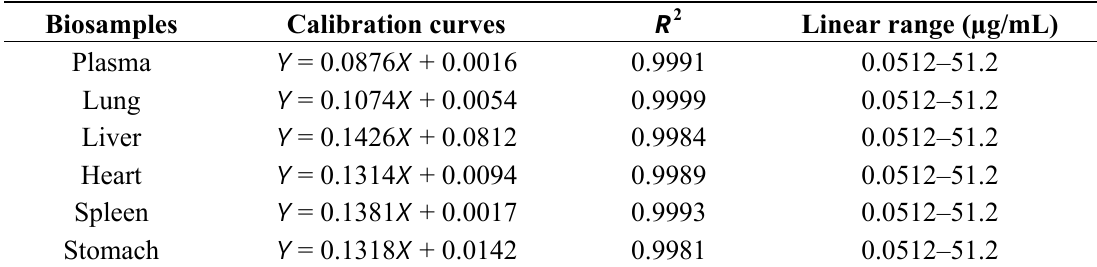
Table 1. The calibration curves, coefficients and linear ranges of PD in plasma and tissue